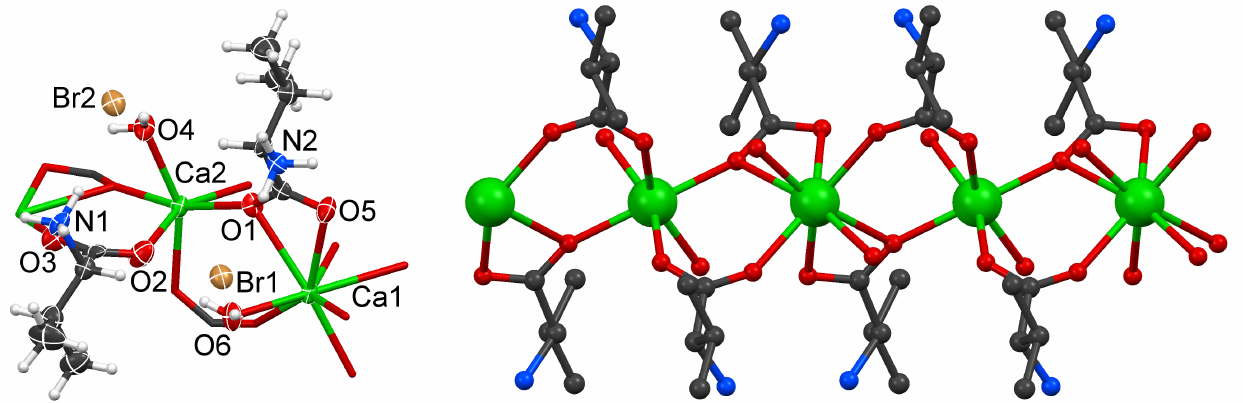
Left: Asymmetric unit of 2 drawn as ellipsoid pot at 80% probability and connected atoms as stick model. Right: Cationic chain of 2 .